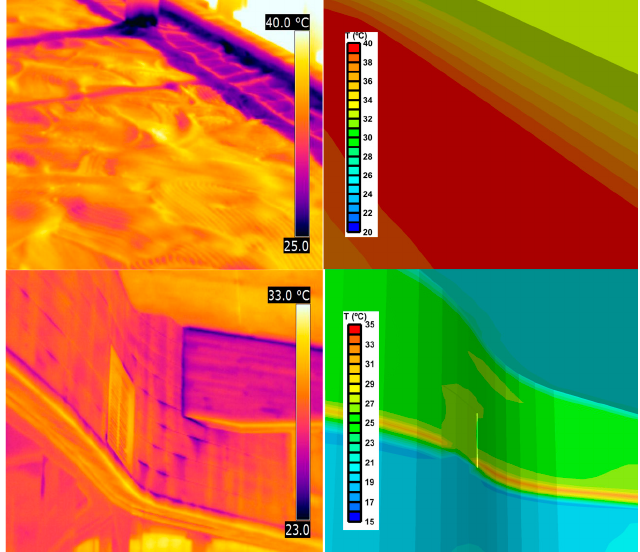
Figure 8. Thermographs of two interior zones in the sunspace: the sand surface ( top left ) and a view of the interior separation ( bottom left ); 23rd of February 2012 at 13:00; solar radiation on horizontal surface 713.42 W/m 2 , exterior temperature 16 °C. Temperature contours in the same zones using numerical model ( right ).